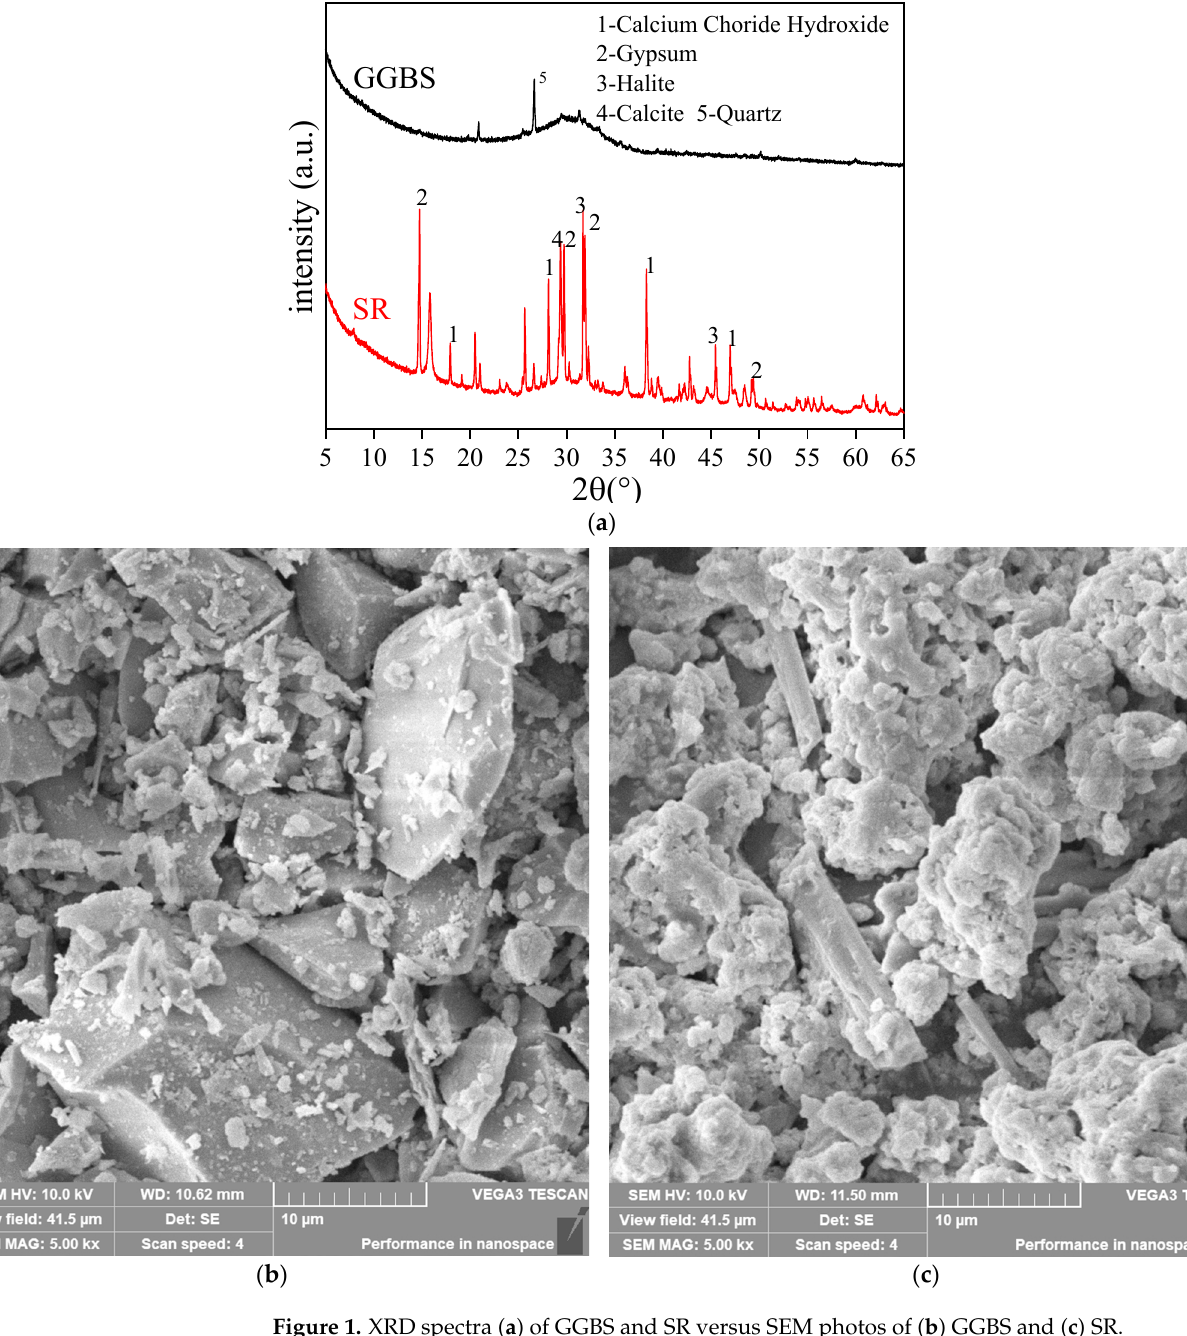
Figure 1. XRD spectra ( a ) of GGBS and SR versus SEM photos of ( b ) GGBS and ( c ) SR. Table 1. Chemical constituents of raw materials (wt/%), data from [23].